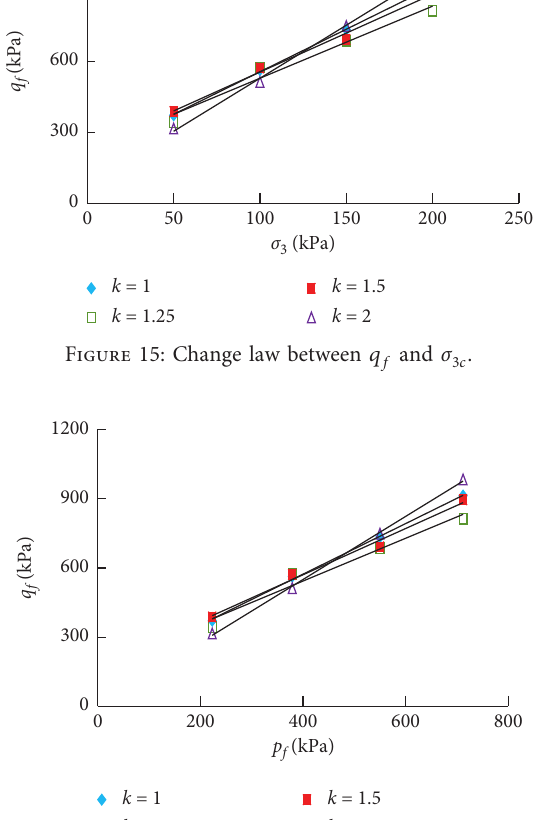
f and k in a failure state.